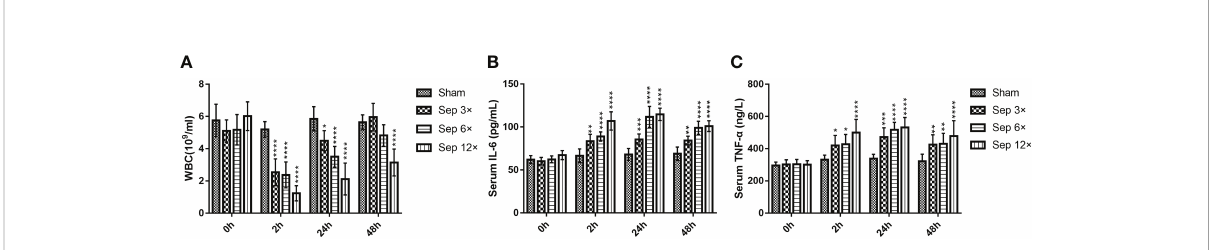
FIGURE 3 Changes in WBC (A) , serum IL-6 (B) , and serum TNF- a (C) in rats at different E coli concentrations and intervals. Values were shown as mean±SD. *P < 0.05, **P < 0.01, ***P <0.001, and ****P < 0.0001 vs sham